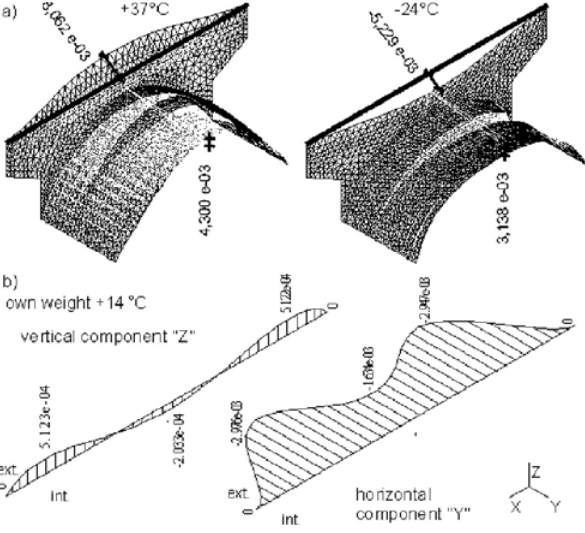
Fig 18. Theoretically calculated characteristic shapes of deformations of the breast wall and the bridge vault due to the temperature effect (+37 °C, –24 °C) and the dead weight effect (a); deformations of the upper edge of the breast wall due to the temperature effect